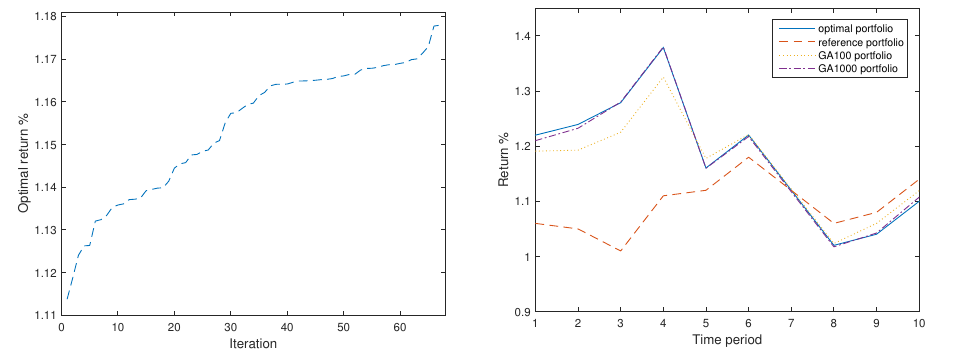
(b) The return of optimal portfolio by ε BBO in each period with benchmark portfolio and the optimal portfolio by GA algorithm Figure 3. The performance of the ε BBO and the optimal portfolio in X ∈ [ 0,1 ] of model (28).